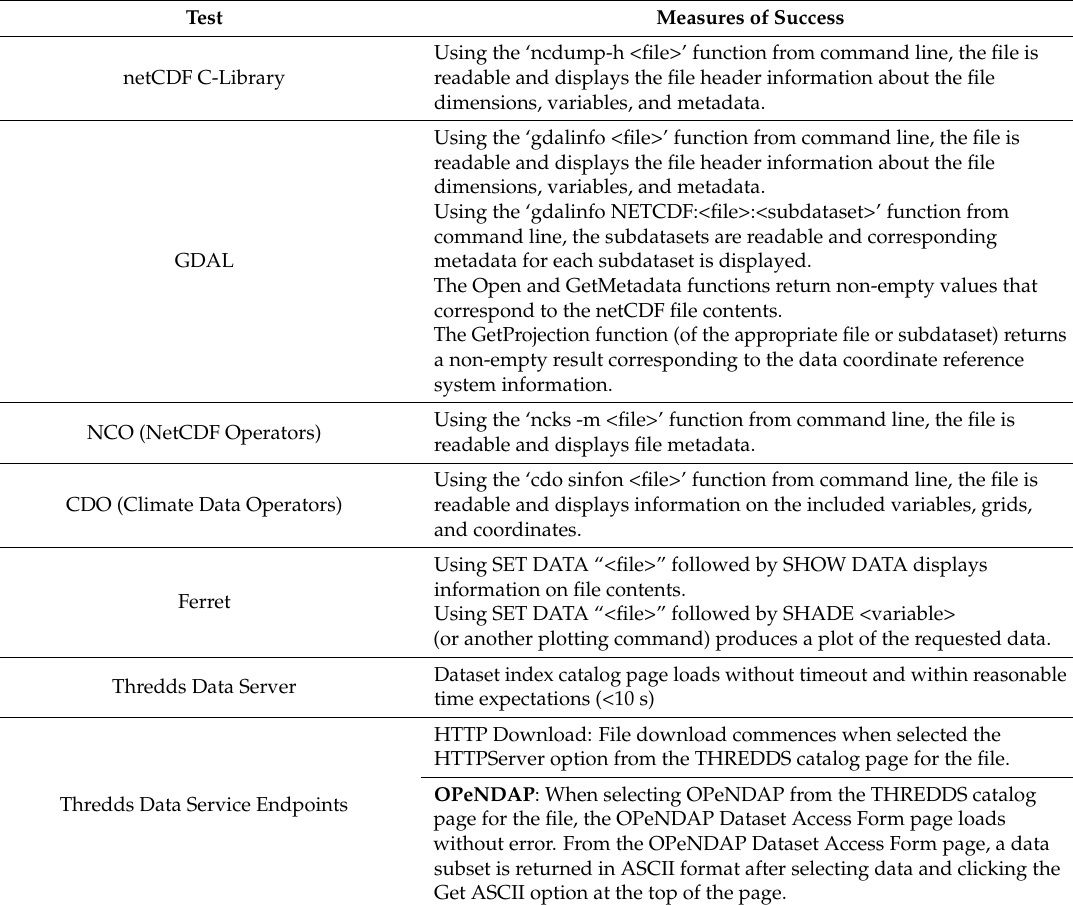
Table 2. Description of basic accessibility and functionality tests that are applied for commonly used tools as part of NCI’s QA